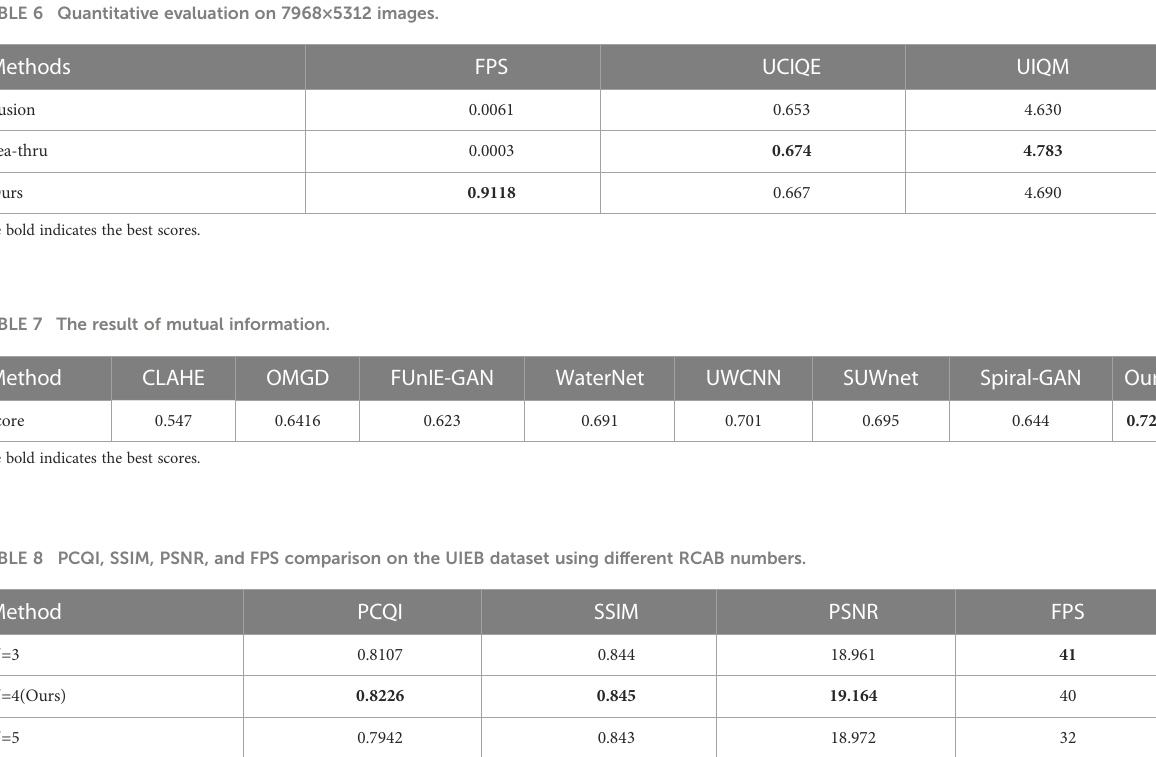
The bold indicates the best scores.